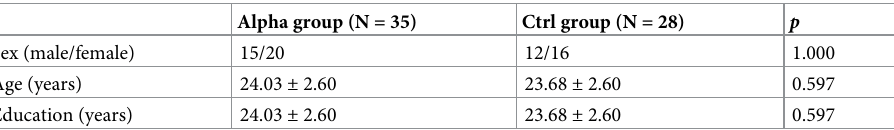
Table 1. Demographics of the Alpha and Ctrl